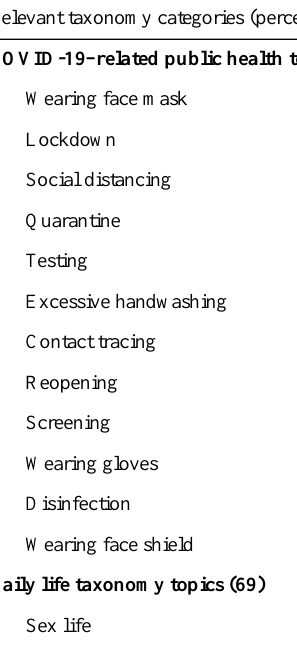
Number of posts with mentions (percent classified within category)Relevant taxonomy categories (percent classified within all posts) and